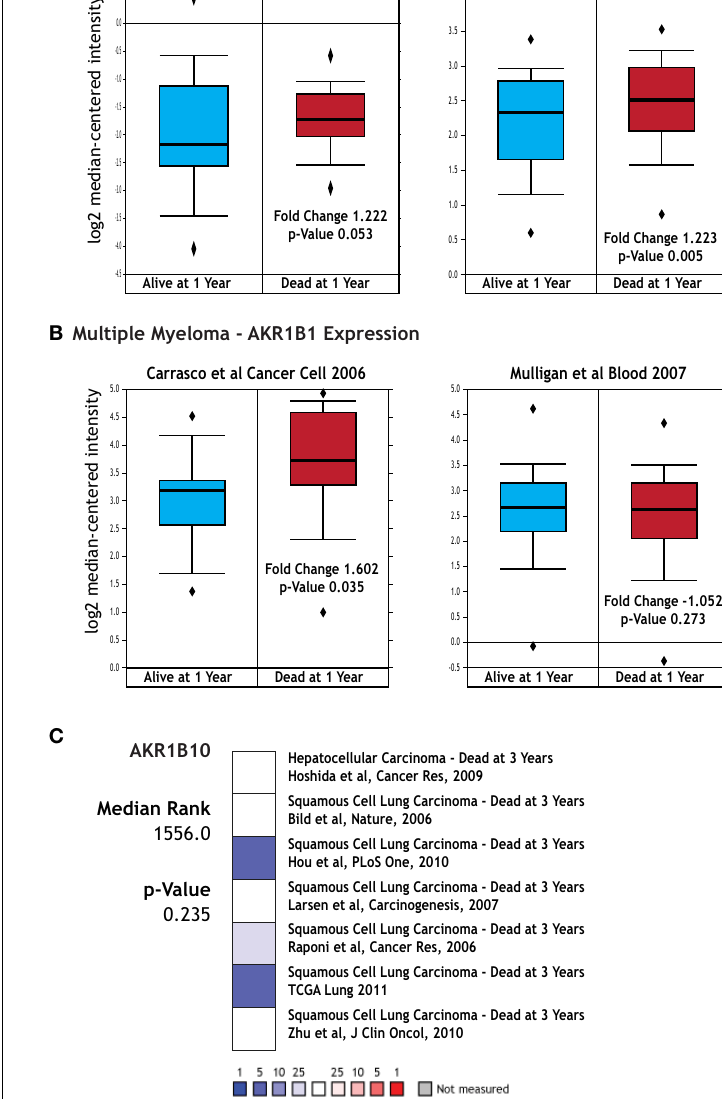
at 1year post diagnosis. Individual p -values are indicated within each box plot and the p -value and median gene rank for all three studies is at the right of the panel. (C) AKR1B10 expression relative to clinical outcome in liver cancer and squamous cell lung cancer. Colored boxes are a heatmap-style representation of AKR1B10 expression in patients dead relative to those alive at 3years post diagnosis, with blue indicating under-expression and red over-expression. Median rank and p -value for this panel considers all indicated studies